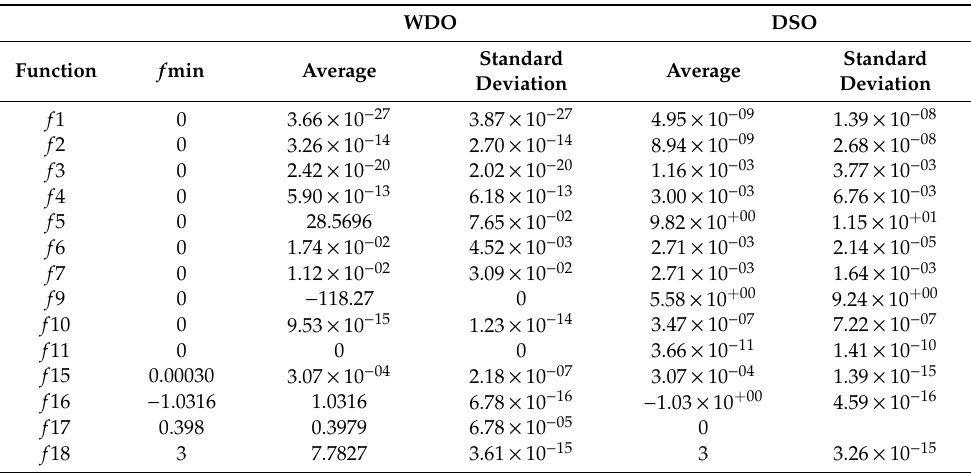
Table 7. Results for 30